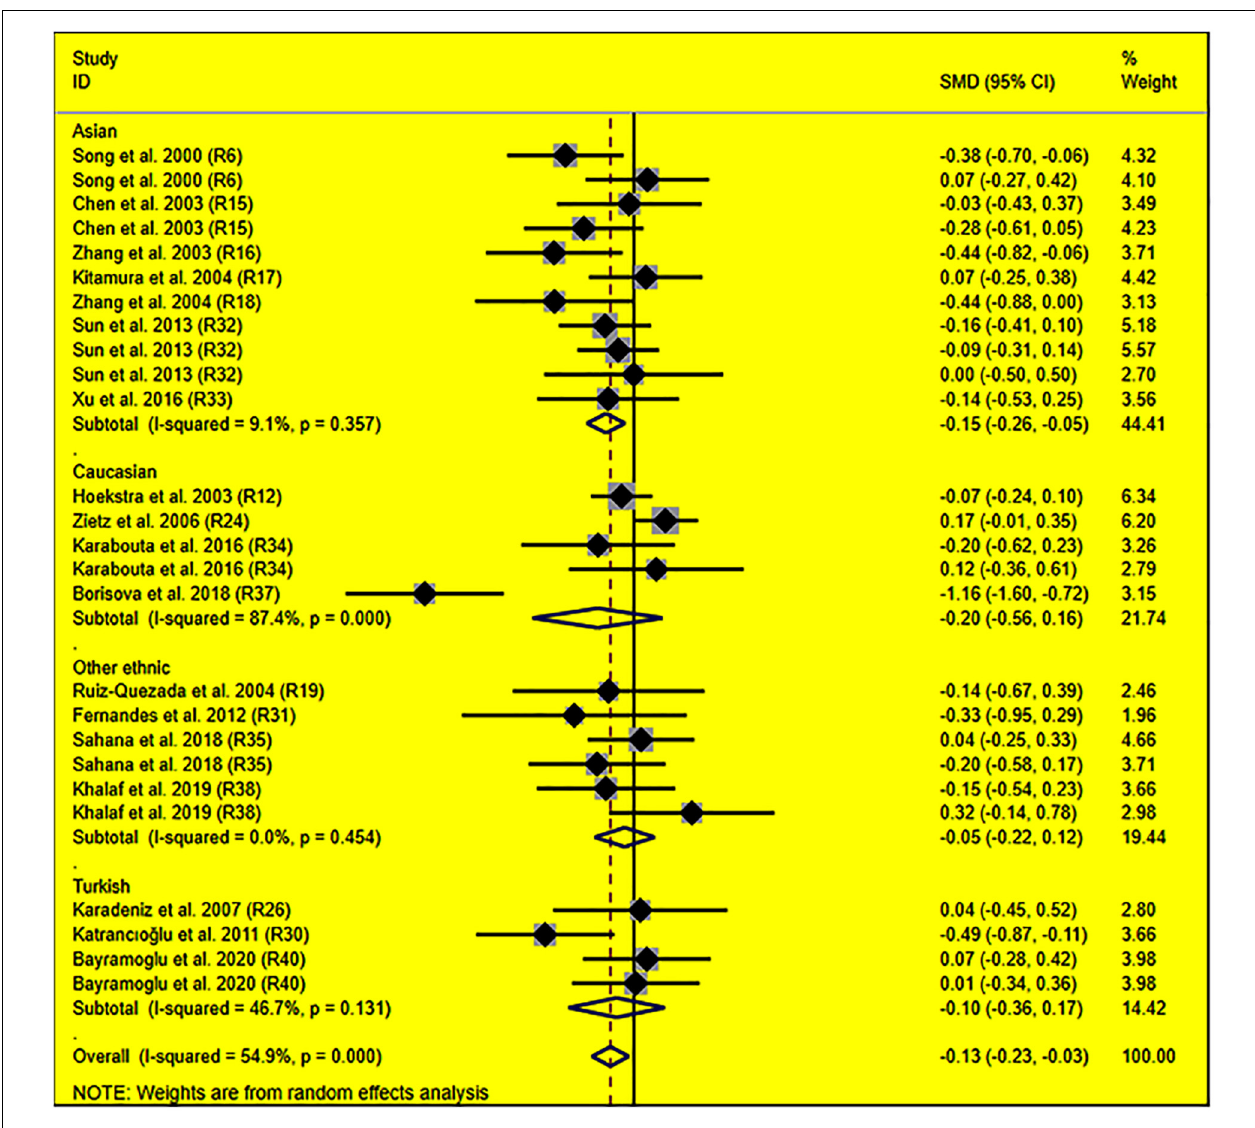
FIGURE 2 | Forest plot of the meta-analysis between SERPINE1 rs1799889 polymorphism and circulating LDL-C